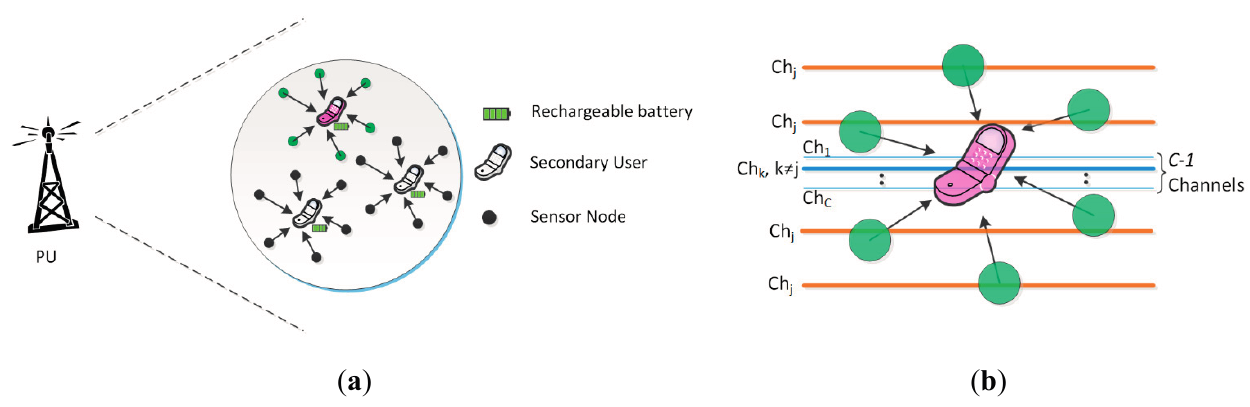
Figure 1. ( a ) Sensors-assisted cognitive radio network operating in the coverage area of the primary network. PU represents the PU-transmitter; ( b ) Sensor nodes sensing the operating channel, and the SU sensing the (cid:1829) − 1